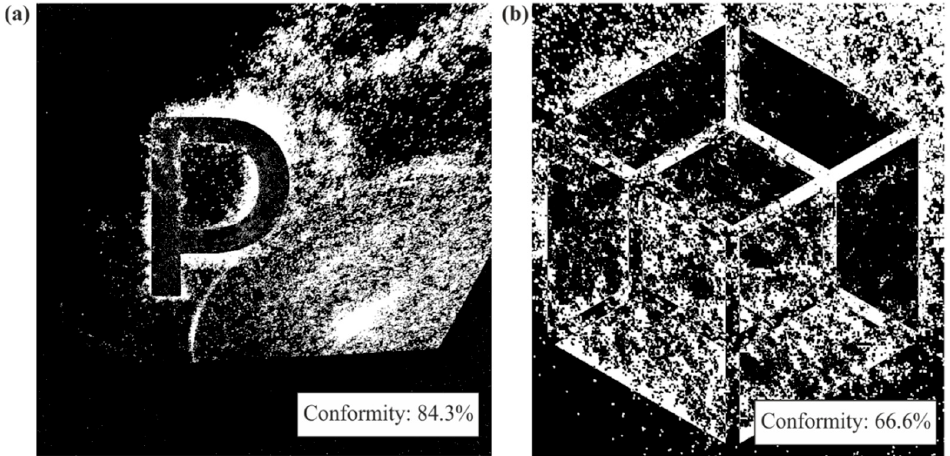
Figure 7. Conformity of original and reconstructed images.